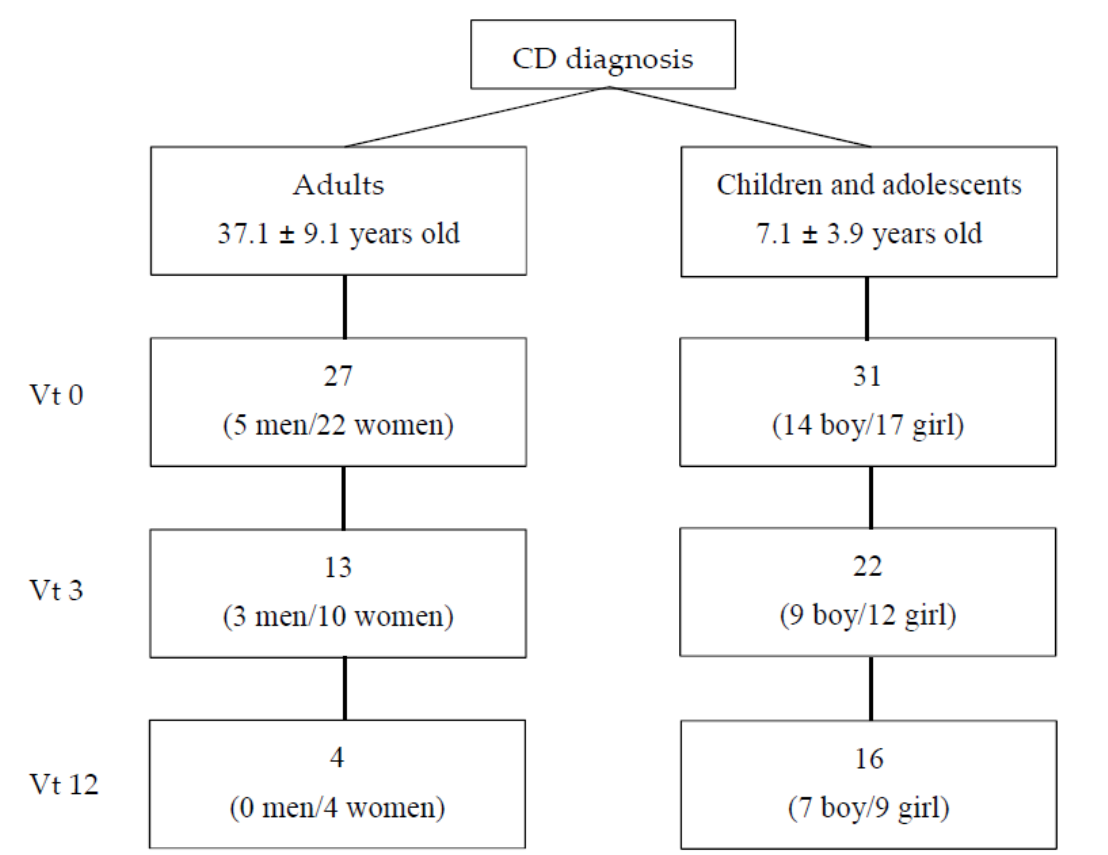
Figure 1. Patients included in the study. Vt0: visit at time 0, at diagnosis; vt3: visit after 3 months on a gluten-free diet; vt12: visit after 12 months on a gluten-free diet.